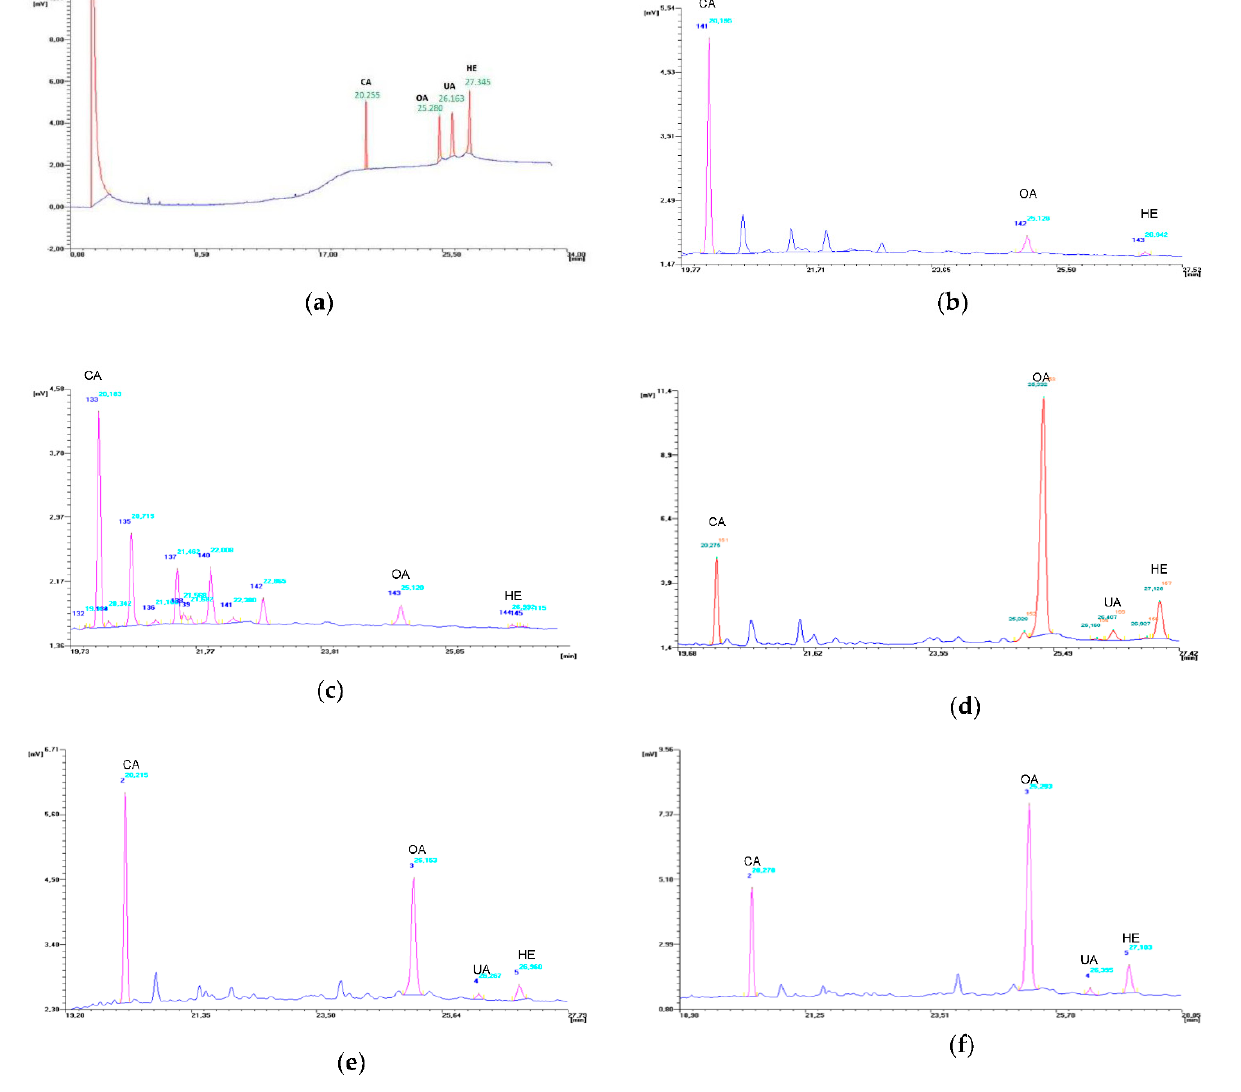
Figure 6. GC chromatograms: ( a ) mixture of the trimethylsilyl derivatives of standard substances: oleanolic acid (OA), ursolic acid (UA), hederagenin (HE) and cholesterol acetate (CA); ( b )extract of nonembryogenic callus; ( c ) extract of embryogenic callus; ( d ) extract of TSE regenerants; ( e ) extracts of TSE plants ex vitro; ( f ) extract of donor plant.